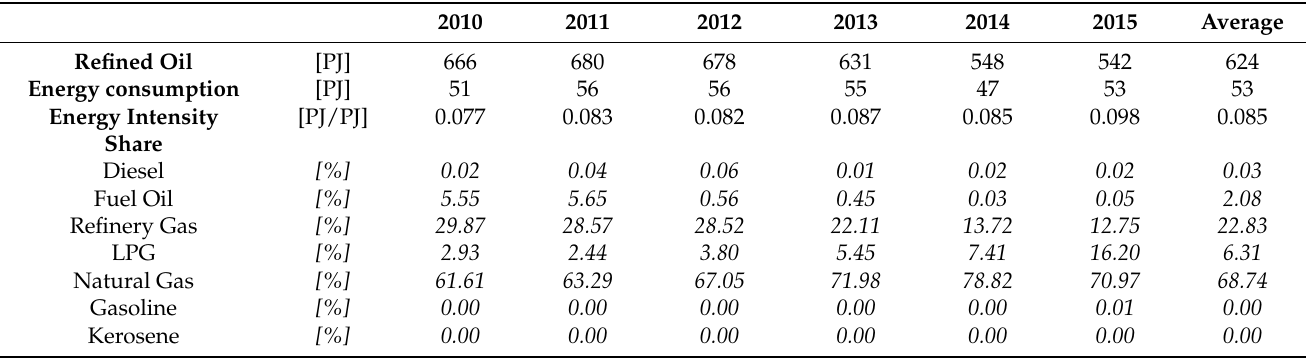
Table A1. Refineries energy demand [25].